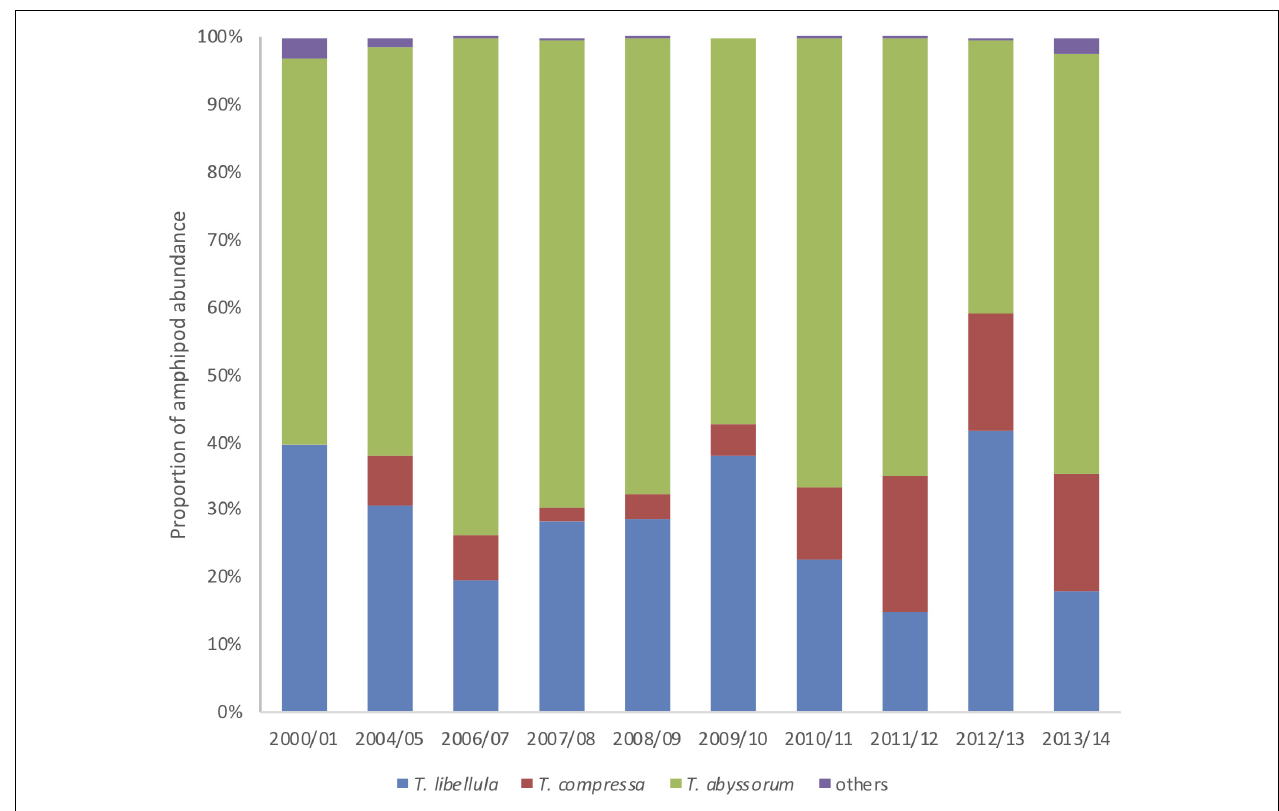
FIGURE 2 | Proportion of amphipod abundances (%) at HAUSGARTEN Central Station per sampling period. Details for the years 2009/10 and 2010/11 can be found in the Supplementary Material .